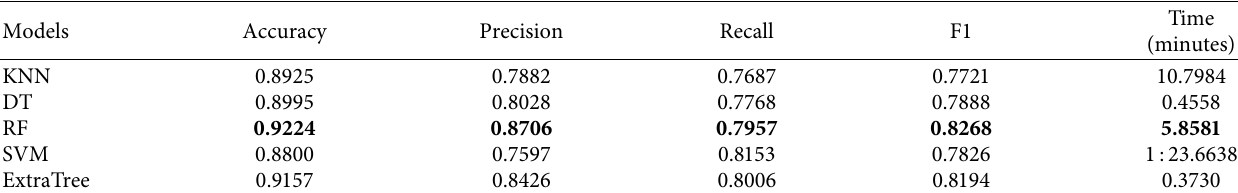
Figure 3. The variable definitions of 28 features are depicted in Table 2.